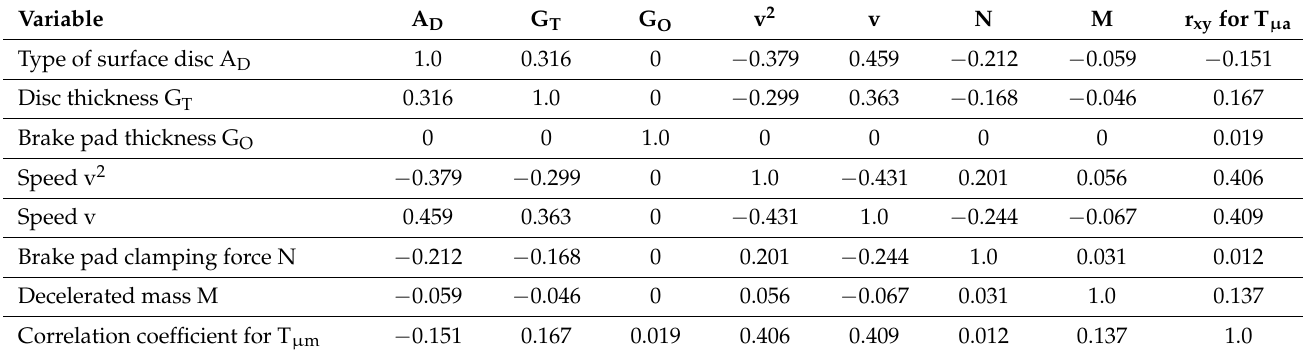
Table 4. Correlation matrix for the tolerance of the instantaneous coefficient of friction T µ a .